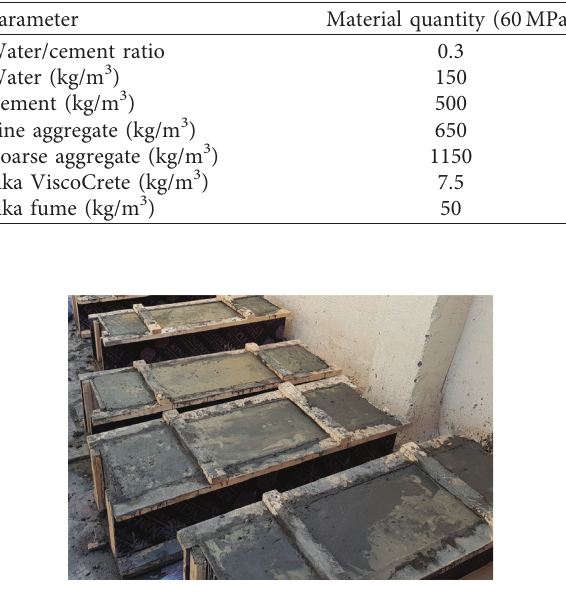
Figure 1: Concrete mixing properties. Table 1: Proportions of concrete mixture.